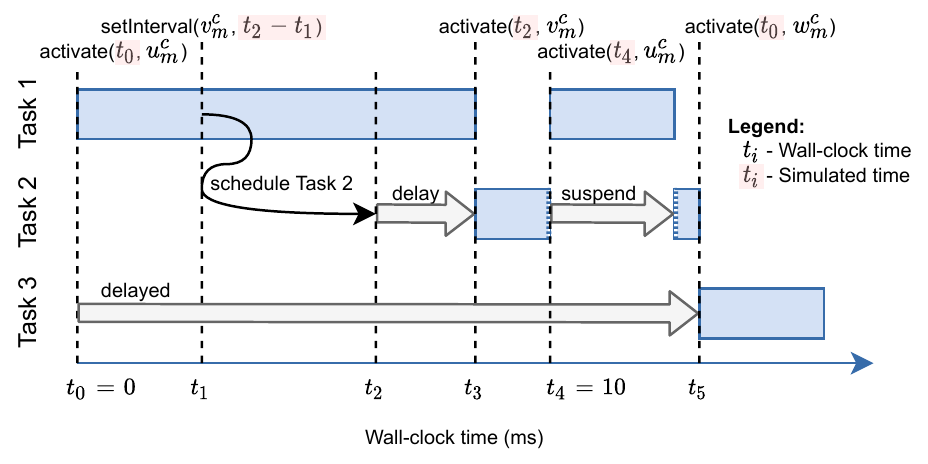
Figure 7. Example execution trace of Figure